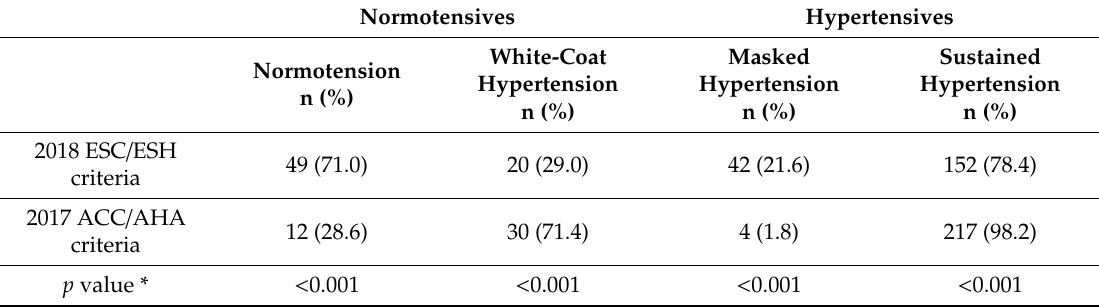
Table 3. Prevalence of white coat hypertension and masked hypertension based on a diagnostic threshold of the 2018 ESC / ESH and 2017 ACC / AHA hypertension guidelines. Referenced to daytime ambulatory blood